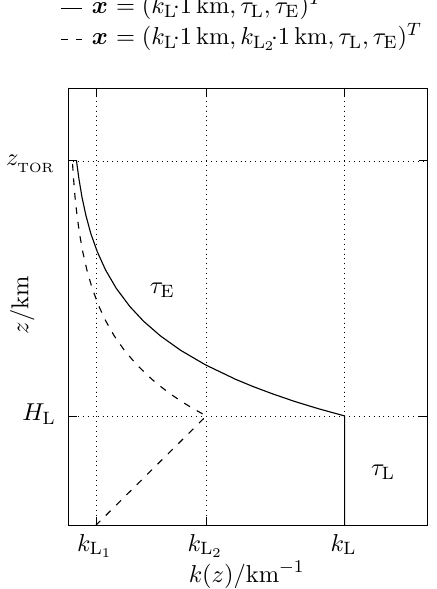
Fig. 1. Parameterisation of the aerosol extinction profile below re- trieval height z TOR : linear from ground to height H L , exponential from H L to z TOR and continuous at z = H L . τ L and τ E are the partial optical depths between ground and H L and H L and z TOR , respec- tively. The three-parameter case with k L mixed